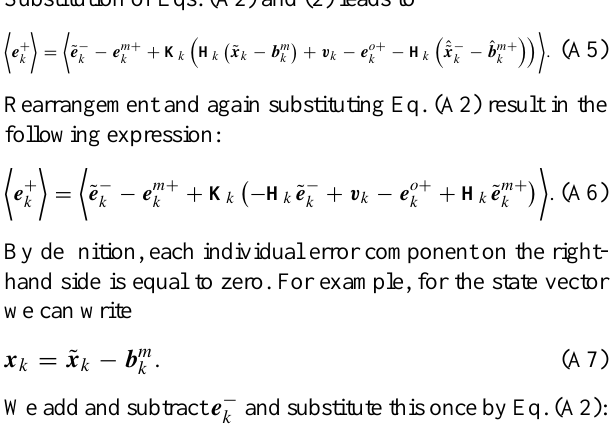
Substitution of Eqs. (A2) and (2) leads